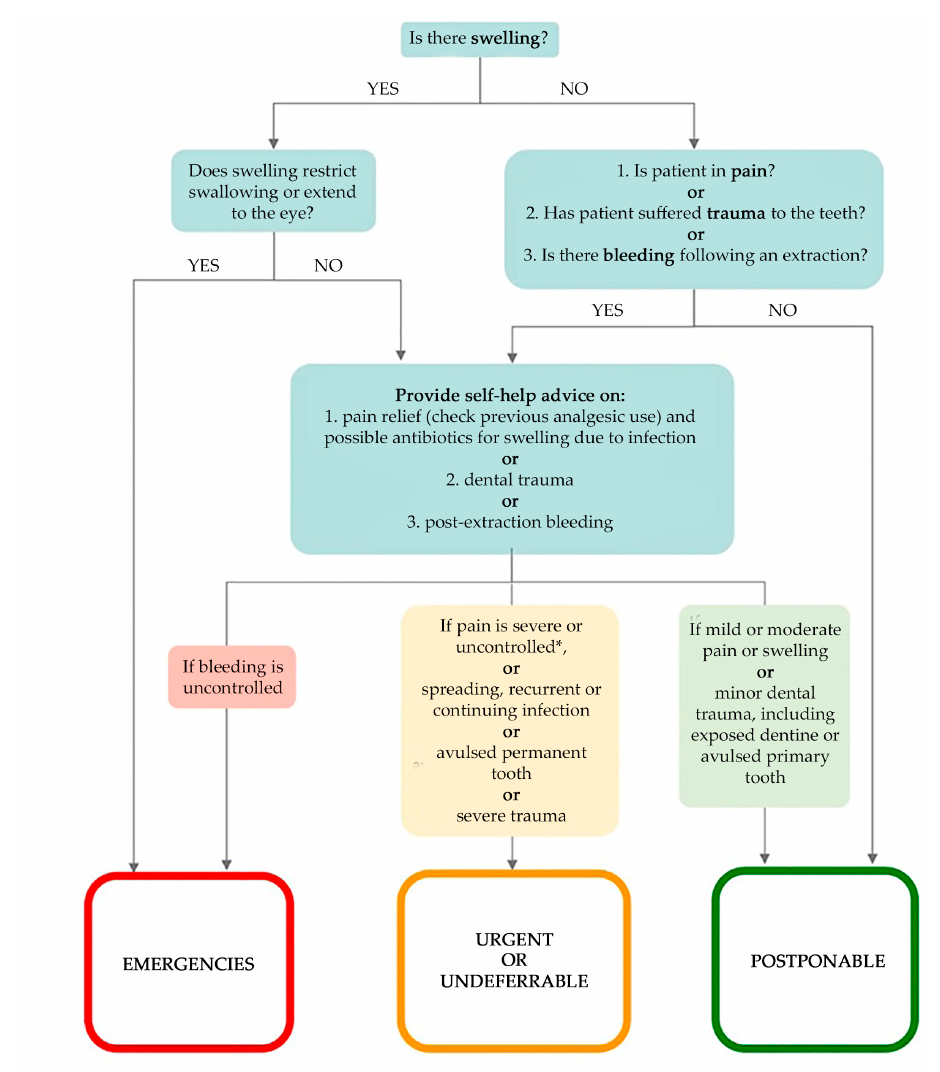
Figure 1. Flow chart of “urgency of treatment” category assignation, a modified version of the one proposed by SDCEP